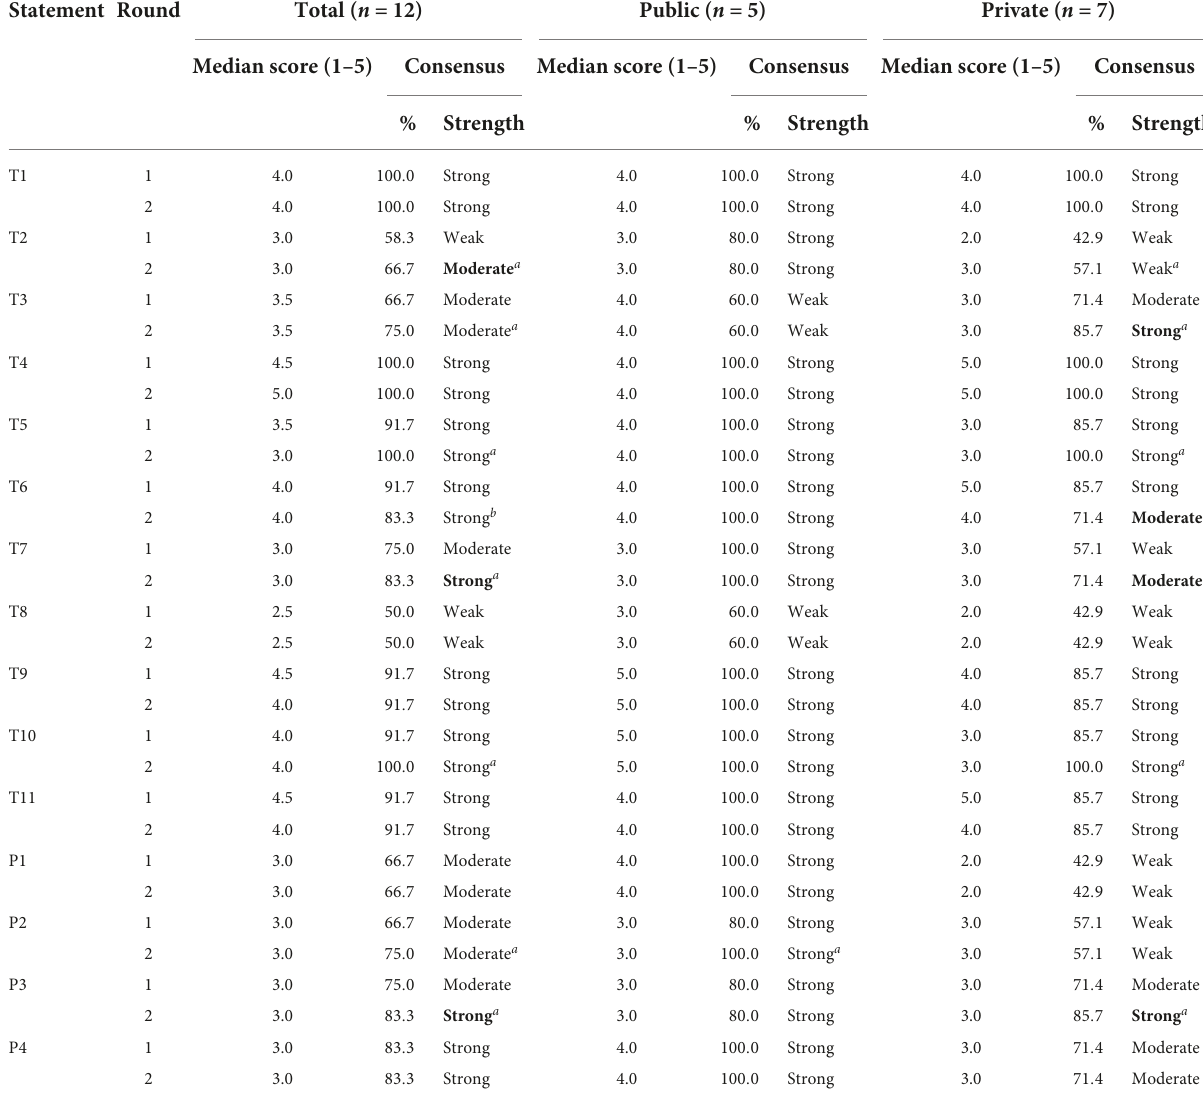
TABLE 3 Consensus on impacts of COVID-19 pandemic on dental